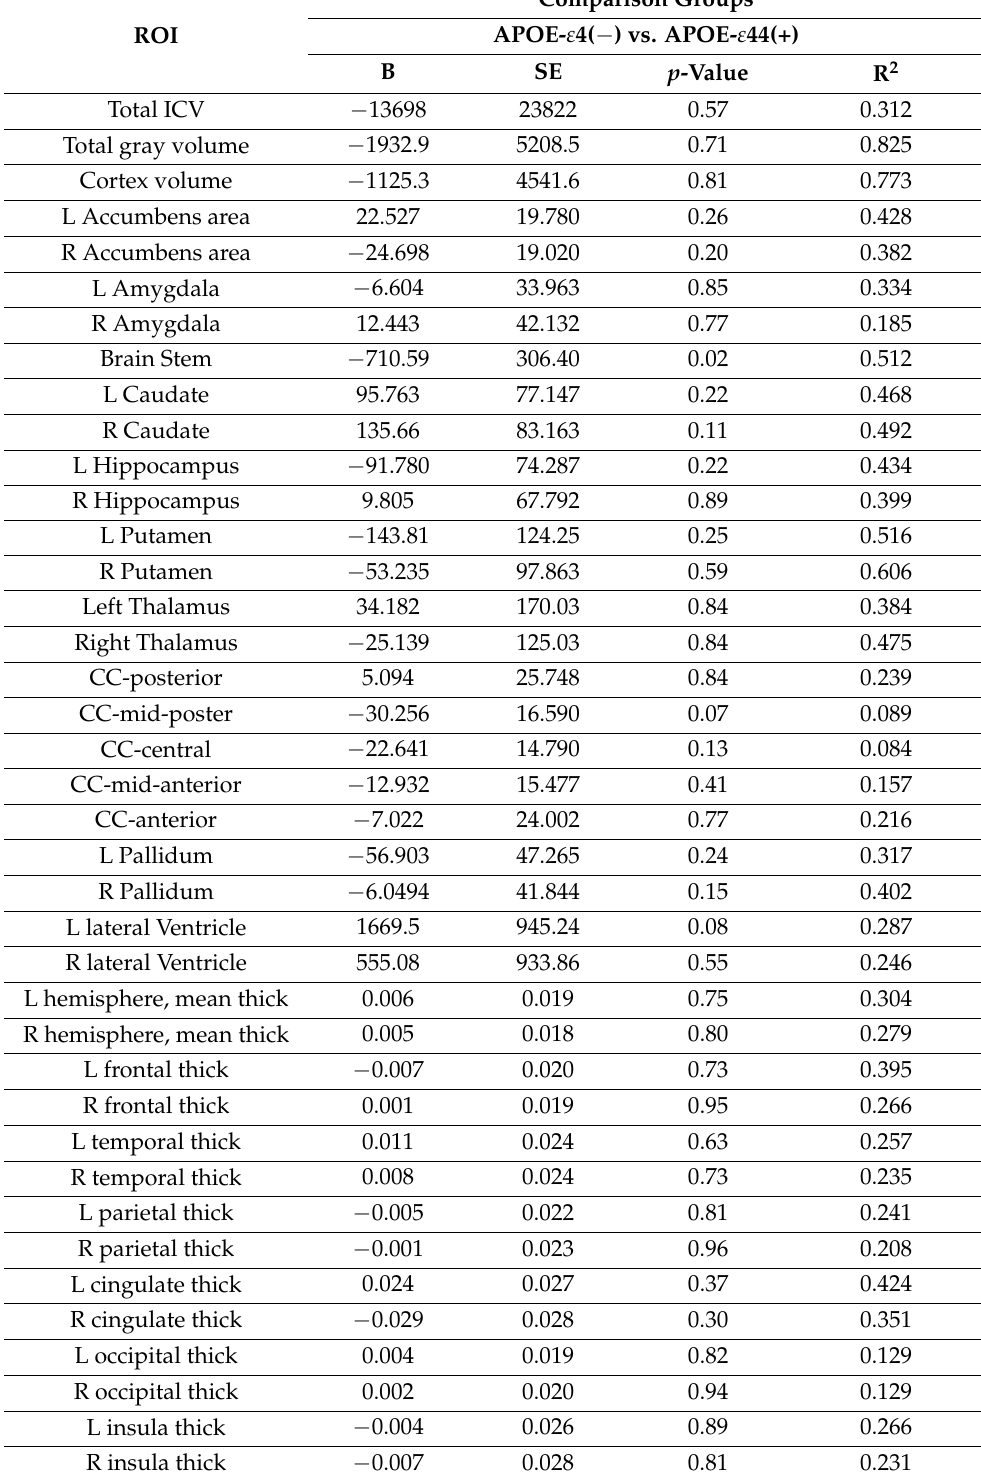
Table 7. Multivariable regression of APOE- ε 4 status and neuroanatomic volume and thickness per